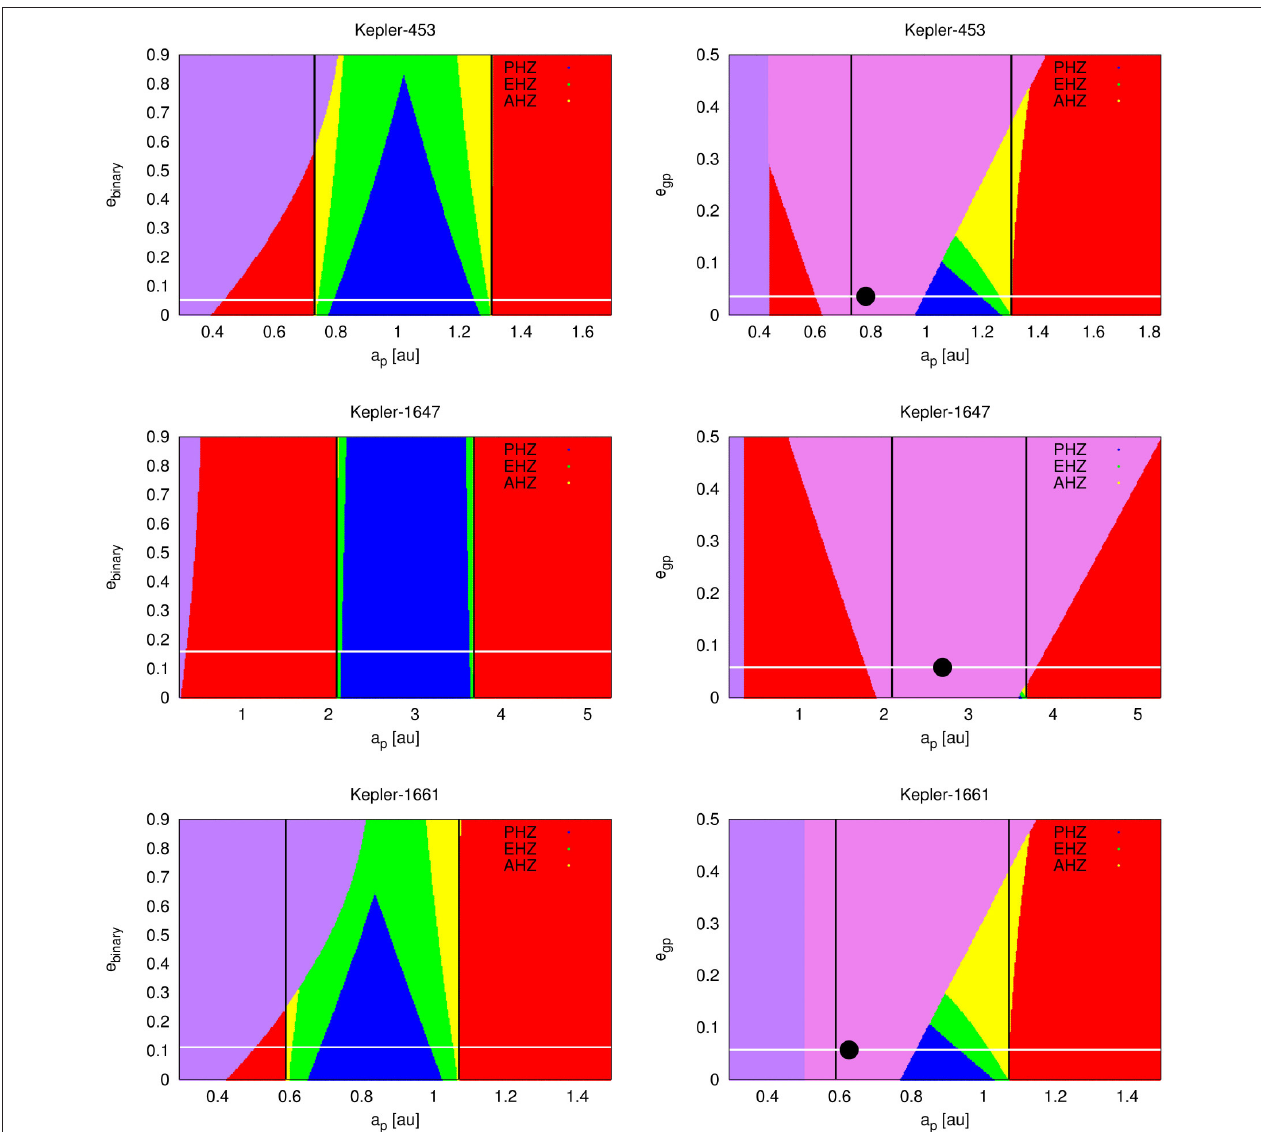
FIGURE 5 | Same as Figure 3 for Kepler-453, Kepler-1647, and